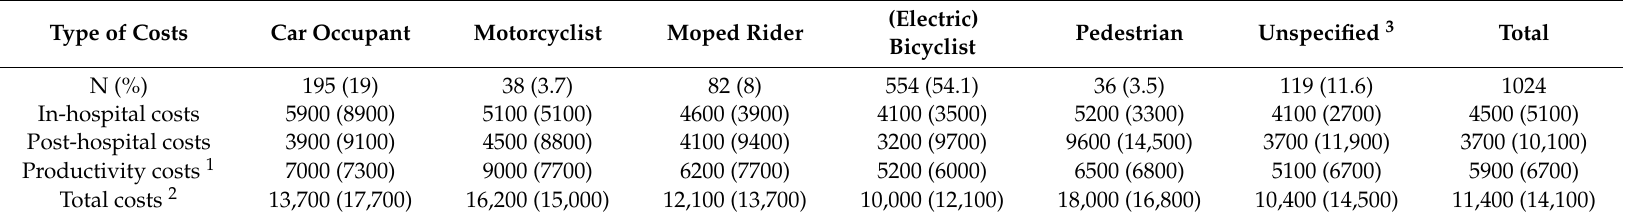
Table 2. Mean (SD) health care and productivity costs of tra ffi c-related injuries by type of road accident, 2017